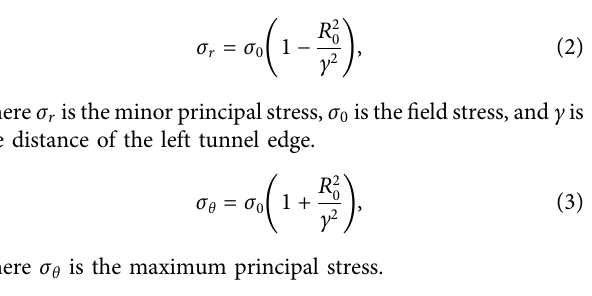
Frontiers in Earth Science |